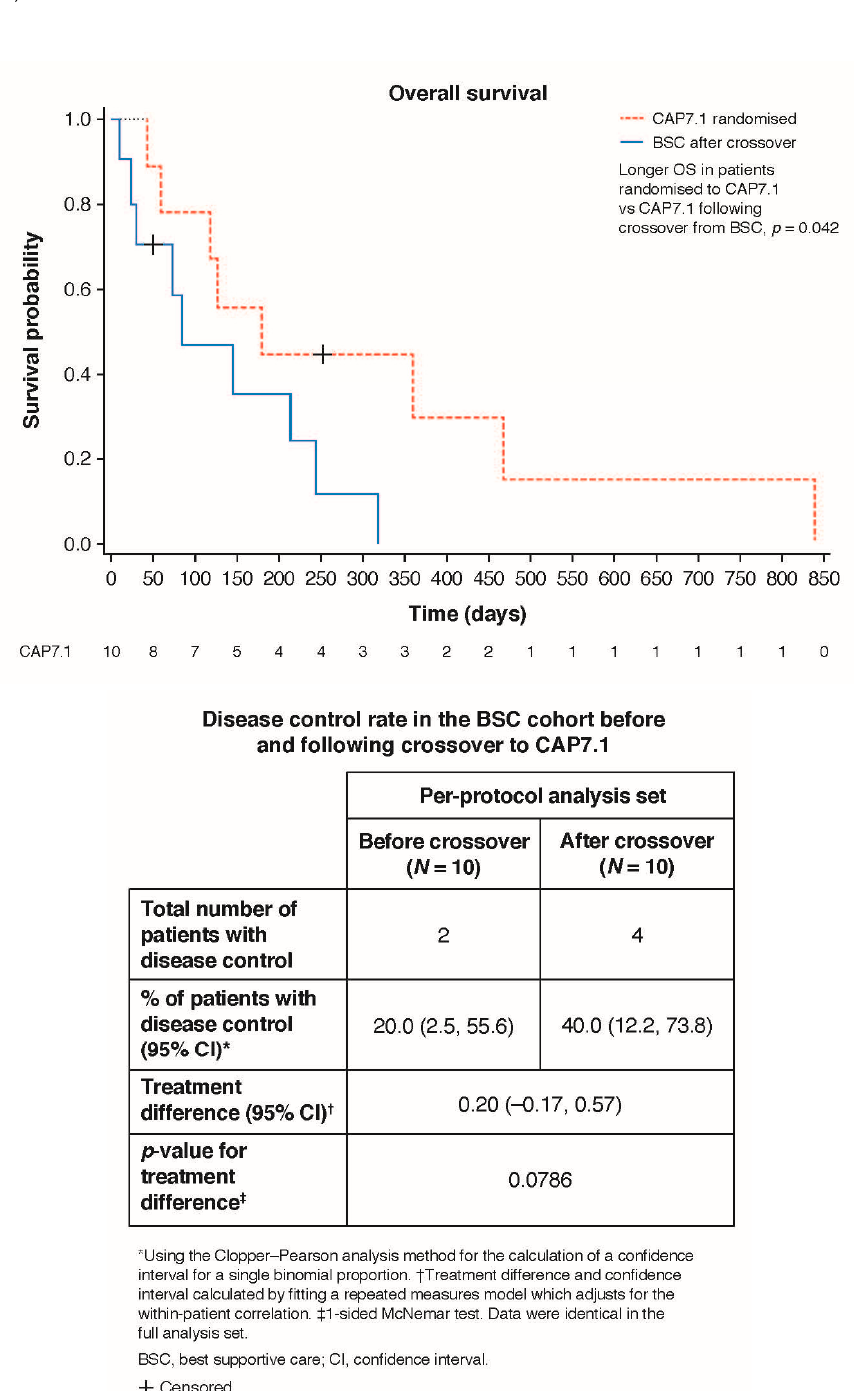
Figure 5. Post-hoc crossover analysis of overall survival (PAS population) and disease control rate (FAS and PAS populations) compared with patients initially randomised to CAP7.1.